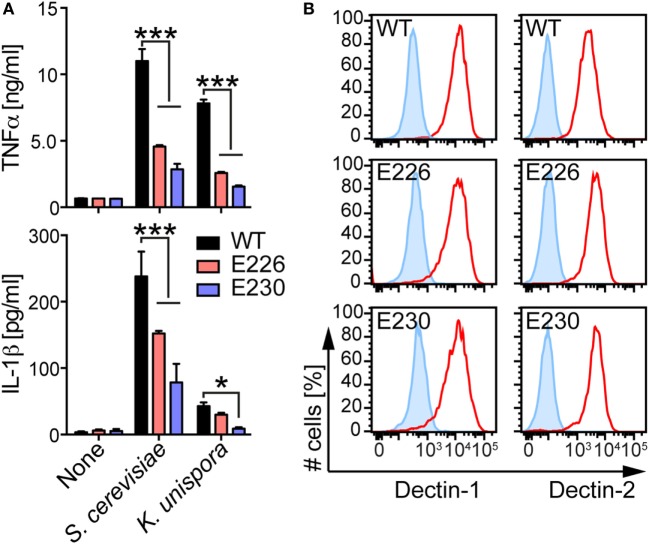
LAP-dependent BMDC cytokine response to commensal yeasts. (A) WT, E226, and E230 BMDCs were incubated with the indicated yeasts at a MOI of 5. After 16 h incubation, the supernatant was harvested and the amount of TNFα and IL-1β was measured by ELISA. (B) WT, E226, and E230 BMDCs were stained with anti-Dectin-1 and 2 Abs (red) or the isotype control Abs (blue). The stained cells were analyzed by flow cytometry. Data shown are the mean of triplicates ± SD from one representative experiment and reproducible in three independent experiments. Statistical analyses were performed by one-way ANOVA followed by Tukey’s test.